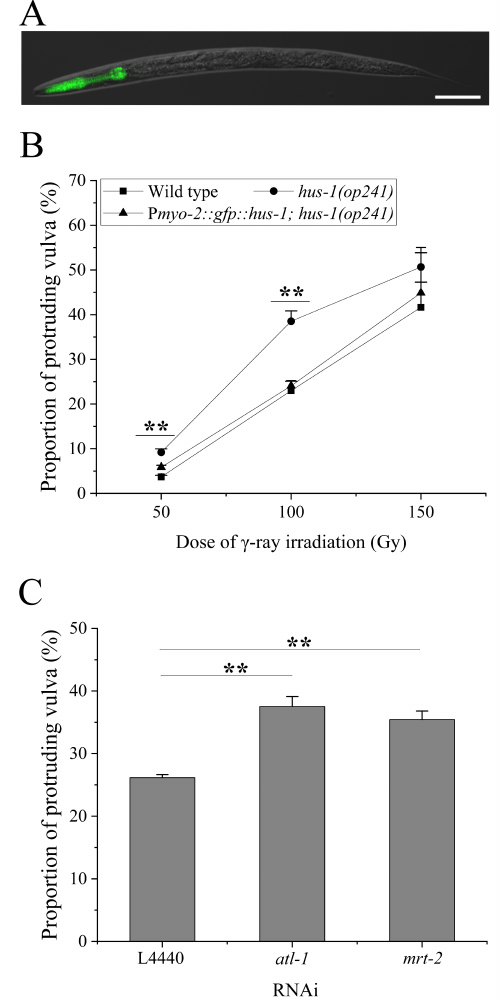
Figure 2. Inter-tissue regulation of pharyngeal ATR cascade on vulval radiosensitivity: ( A ) Pharynx- specific expression of the hus-1 gene in worm line BPL1121: P myo-2::gfp::hus-1; hus-1(op241) , scale bar: 50 µ m; ( B ) the vulval radiosensitivity of BPL1121 worms after exposure to the indicated doses of γ -irradiation; ( C ) the vulval radiosensitivity of BPL1121 worms subjected to RNAi of atl-1 and mrt-2 genes Results are means ± SD ( n ≥ 3, t -test, ** p <